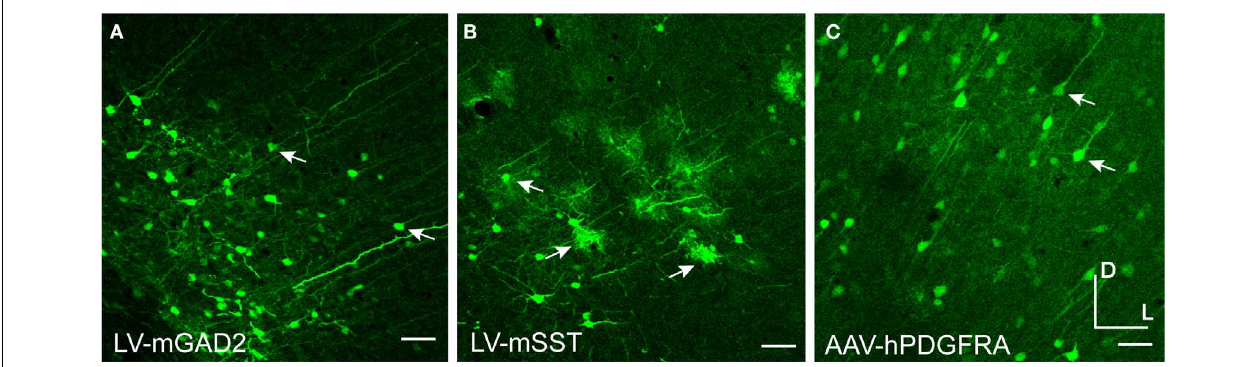
human promoter sequence for platelet-derived growth factor receptor, alpha polypeptide [AAV-hPDGFRA – (C) ]. Rightward pointing arrows mark glia and leftward pointing arrows mark excitatory pyramidal neurons. Dorsal and lateral directions for all images are as indicated in (C) . Scale bars are 50